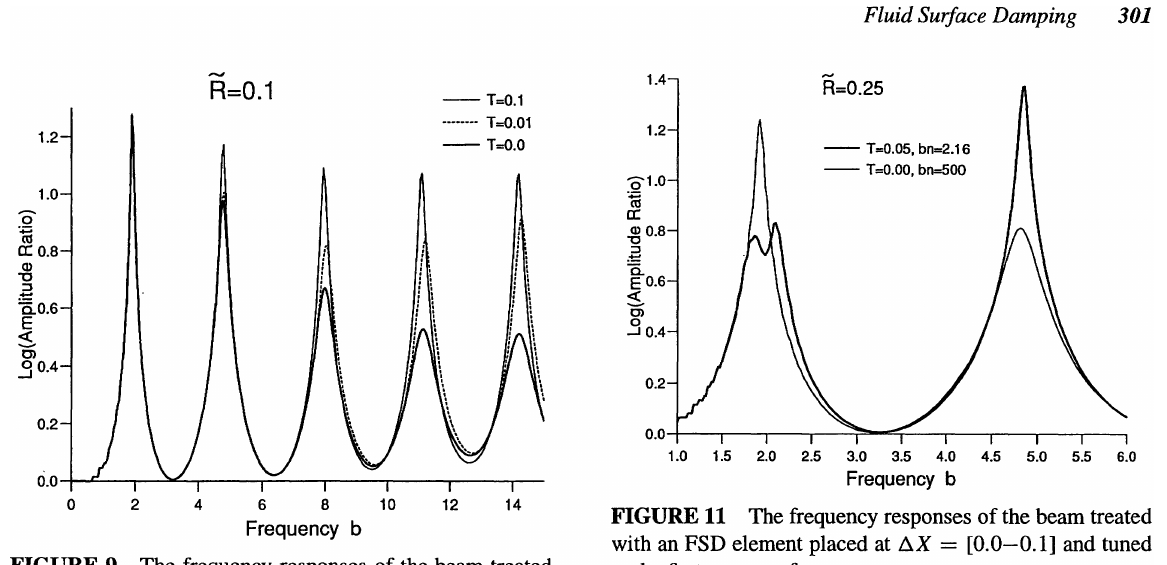
FIGURE 9 The frequency responses of the beam treated with an FSD element placed at AX = [0.0-0.1] for differ ent values of the nondimensional hydraulic time constant, T, and for Ii = 0.1.